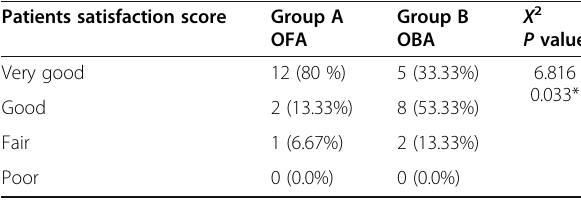
Table 6 Patients ’ satisfaction score Patients satisfaction